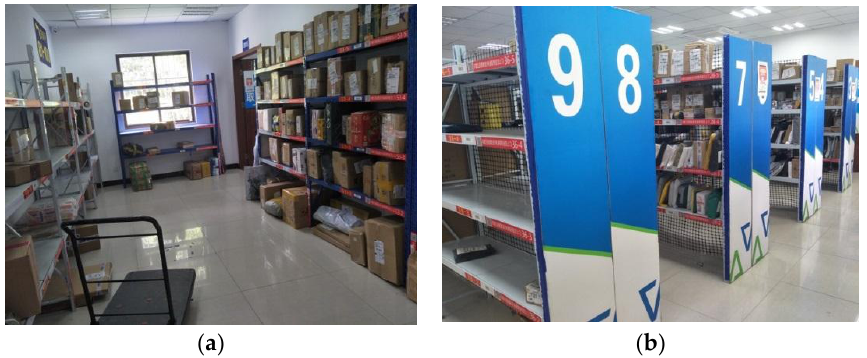
Figure 21. Express post stations. ( a ) Large express parcels situation; ( b ) Small express parcels